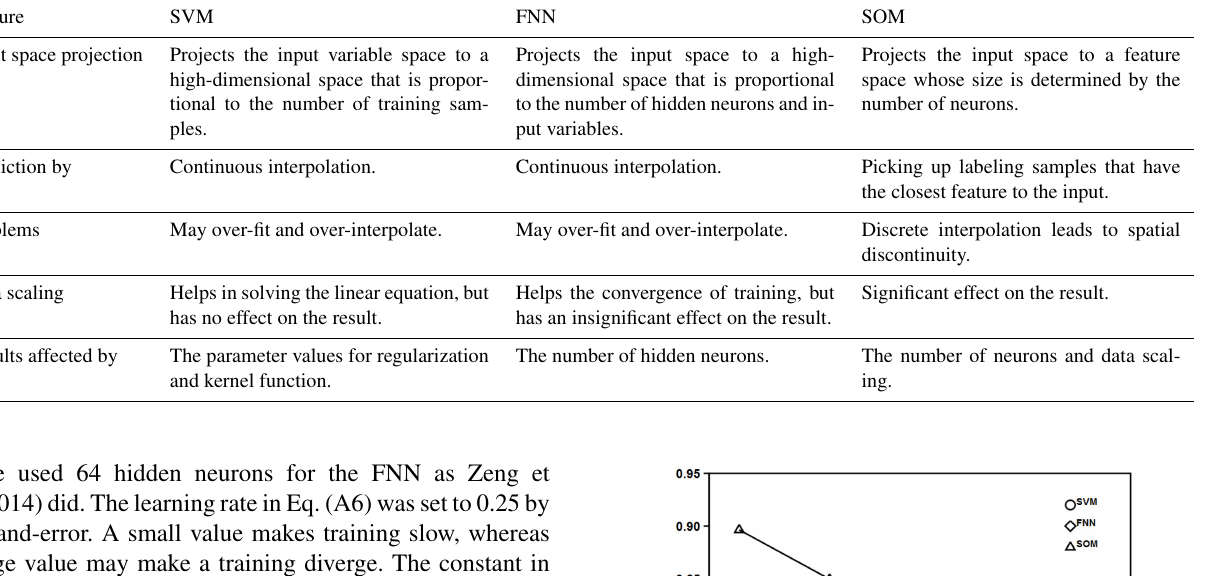
Table 1. Feature comparison of the three machine learning models. Feature